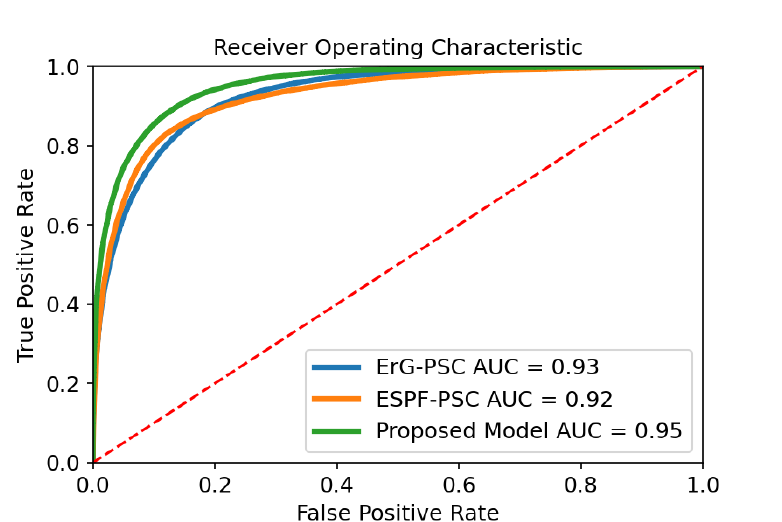
Figure 2. Precision recall curve yielded for two unbalanced models and our proposed method on the BindingDB dataset.